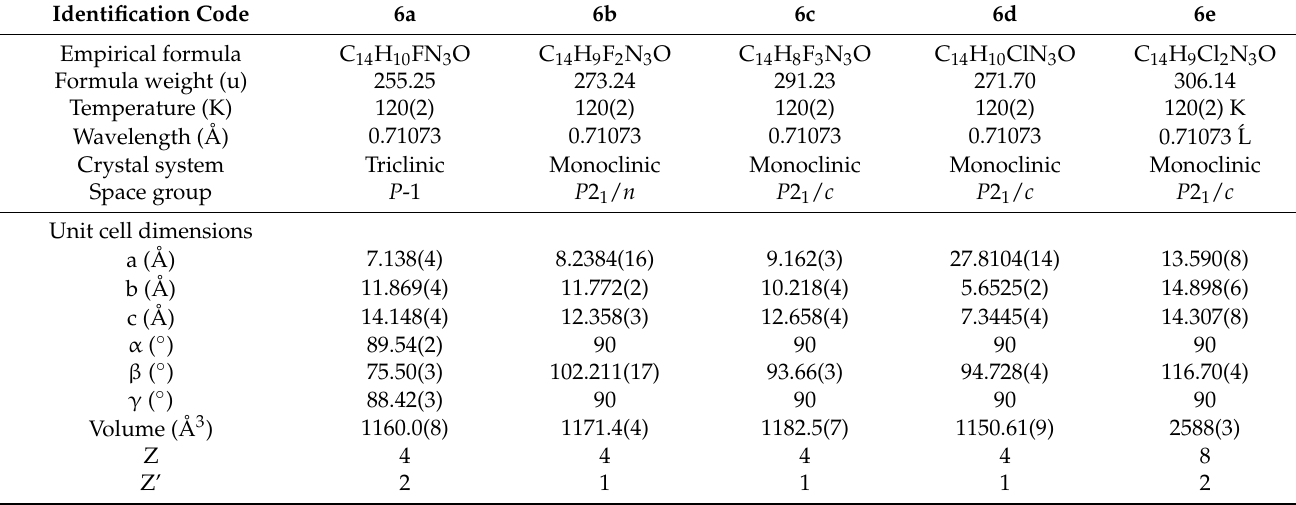
Table 3. Crystal data and structure refinement for 6a – e